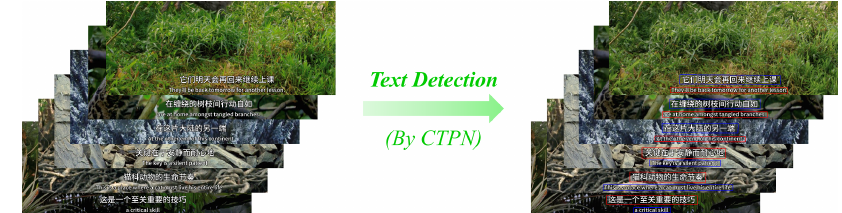
Figure 3. Precise bboxes were obtained with CTPN text detection.